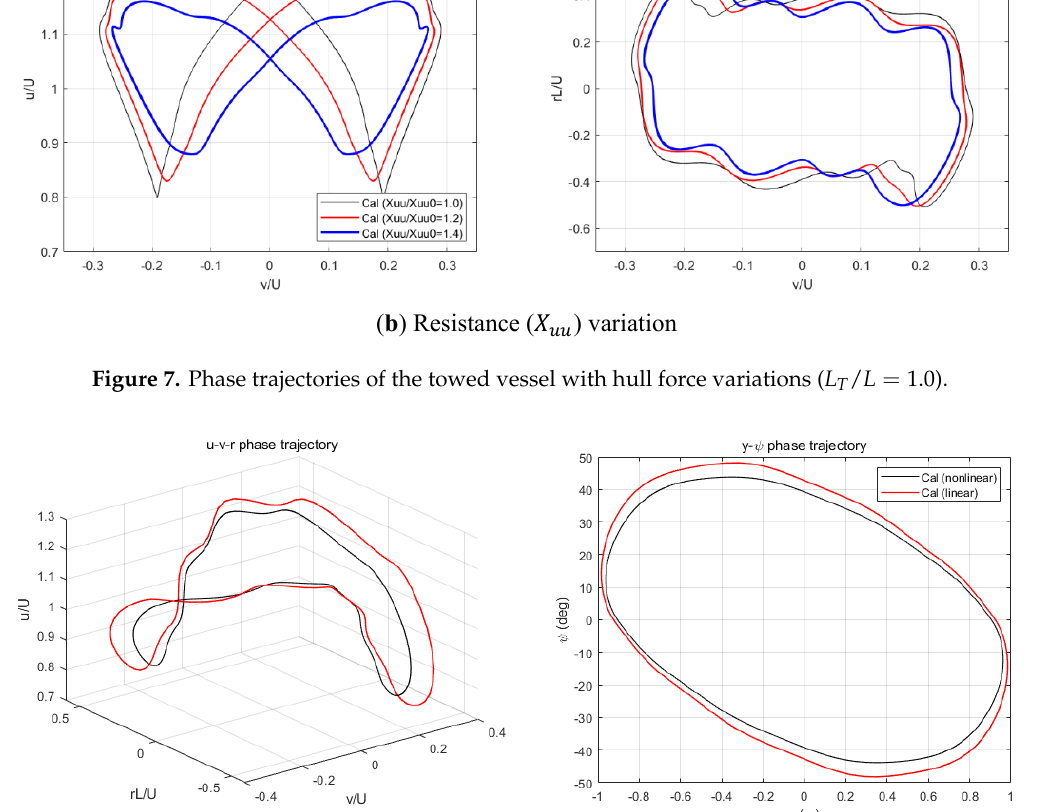
Figure 8. Effect of nonlinear hydrodynamic force model on phase trajectories of the towed vessel.